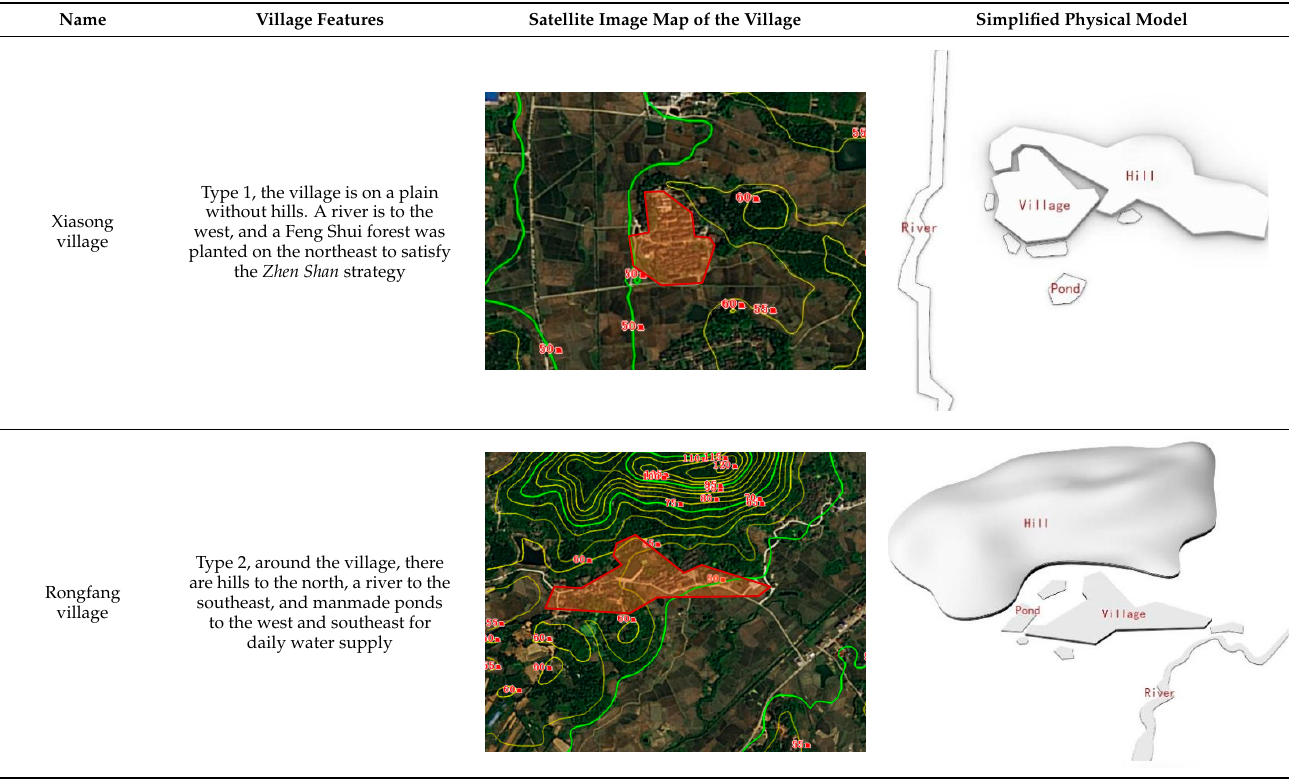
Table 2. Four types of village siting patterns and physical models.